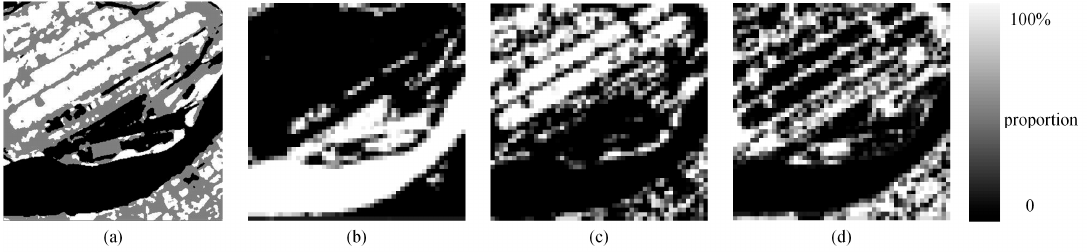
Figure 10. Proportional images of three classes with a scale of 8. ( a ) Reference image, ( b ) water, ( c ) vegetation, ( d ) soil.